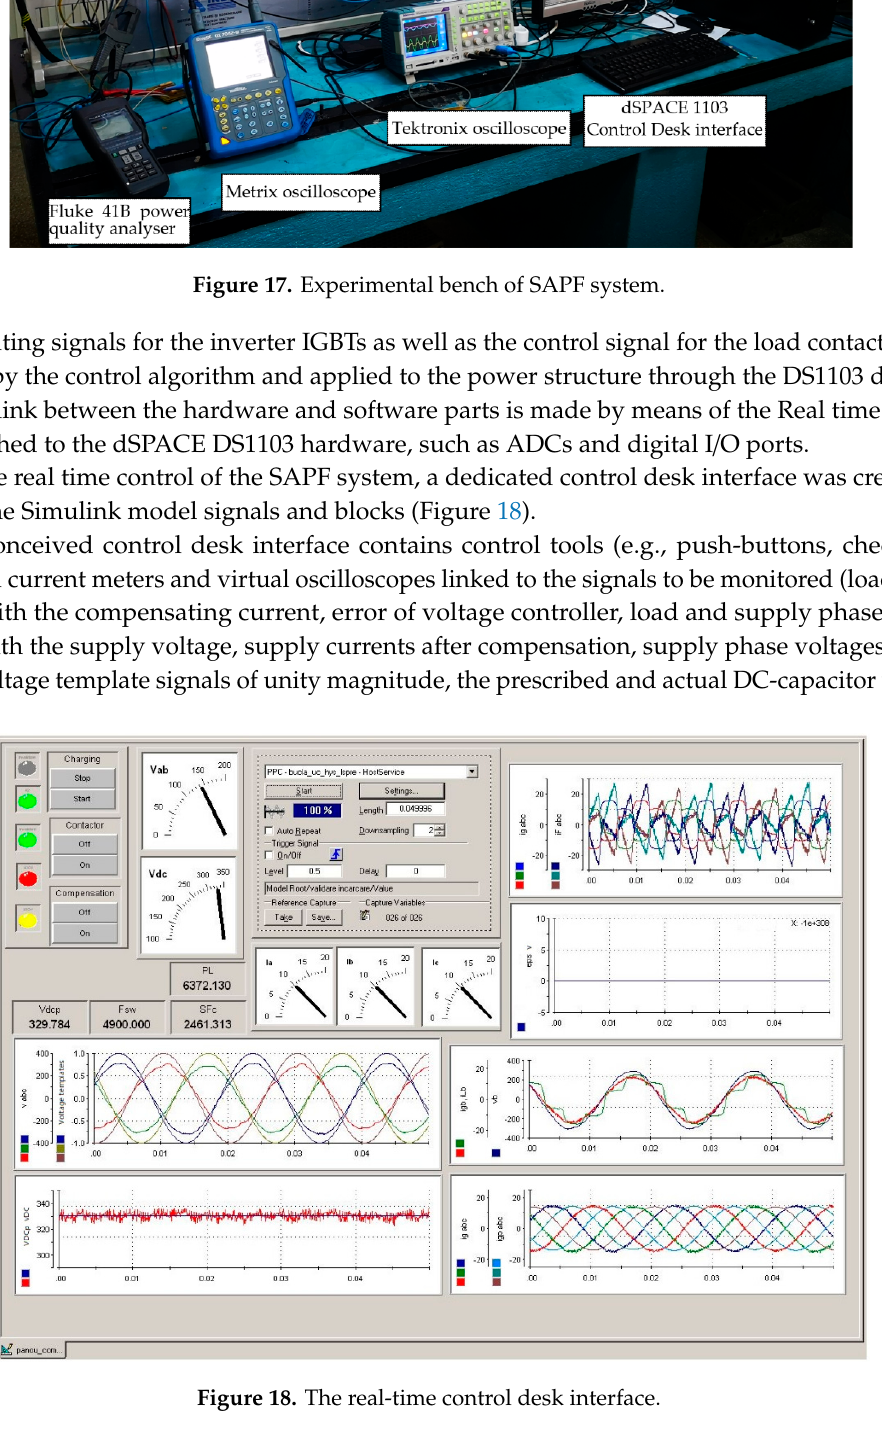
Figure 18. The real-time control desk interface.